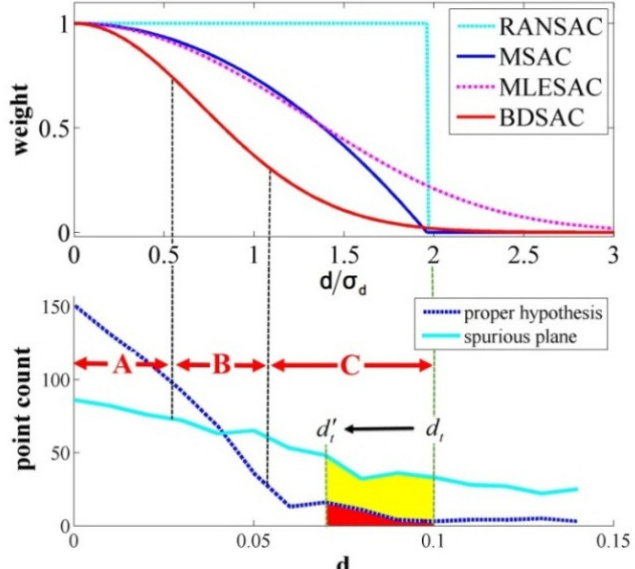
Figure 2. Comparison of point-to-plane distance distribution between proper and improper hypotheses. ( Top ) Plots of the weight functions (d t = 1.96 σ d , MLESAC: γ = 0.3, ν = 3 σ d ); ( Bottom ) Examples of distance distribution for the proper hypothesis and the spurious plane. A, B, and C are a rough division of the distance range: A for regions where the proper planes are dominant in the point count, B for regions where the point counts are similar, and C for regions where spurious planes generate more inliers. The red region represents the lost roof points when using a stricter threshold and the yellow region indicates that more points are excluded from the spurious planes than the proper hypothesis. BDSAC is a newly designed weight curve.